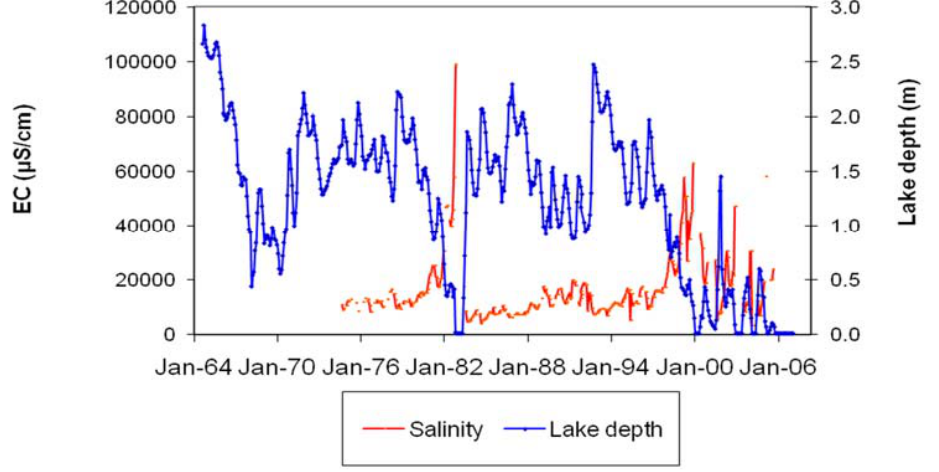
Figure 8. Relationship between measured lake depth and salinity for the period 1964–2007.